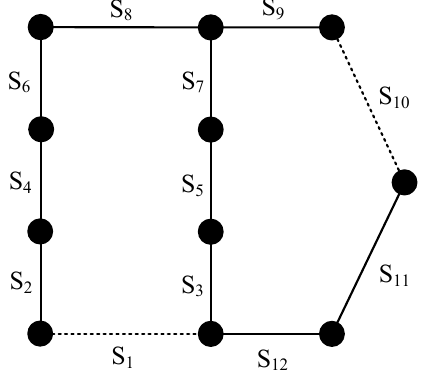
Figure 4. Tutorial system from [19].